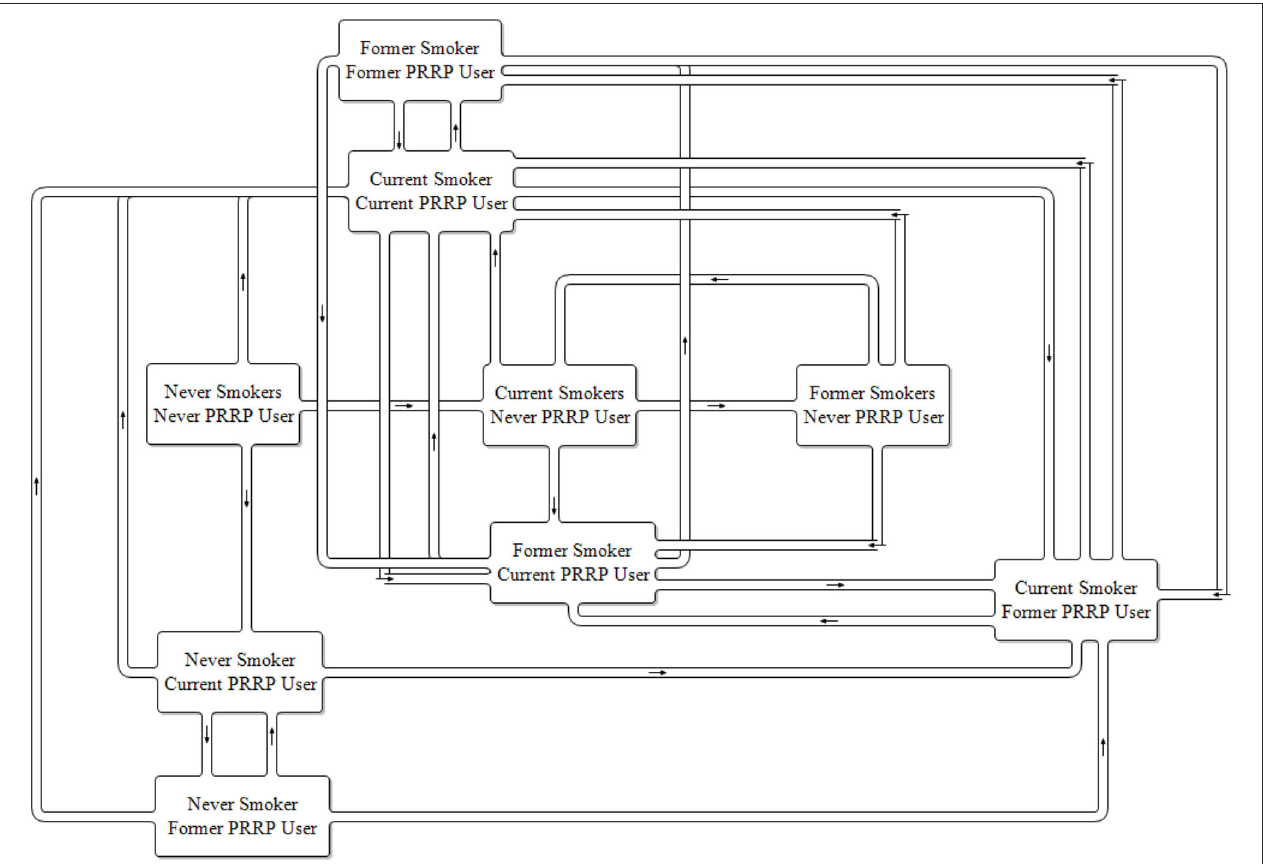
FIGURE 2 | Two product model stock and flow diagram. PRRP, Potentially Reduced Risk Product.